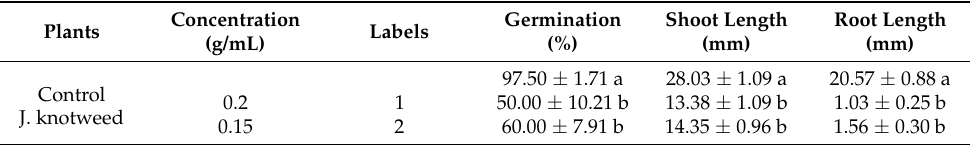
Different letters in the columns indicate statistically significant differences of measured parameters between treatments ( p ≤ 0.05).